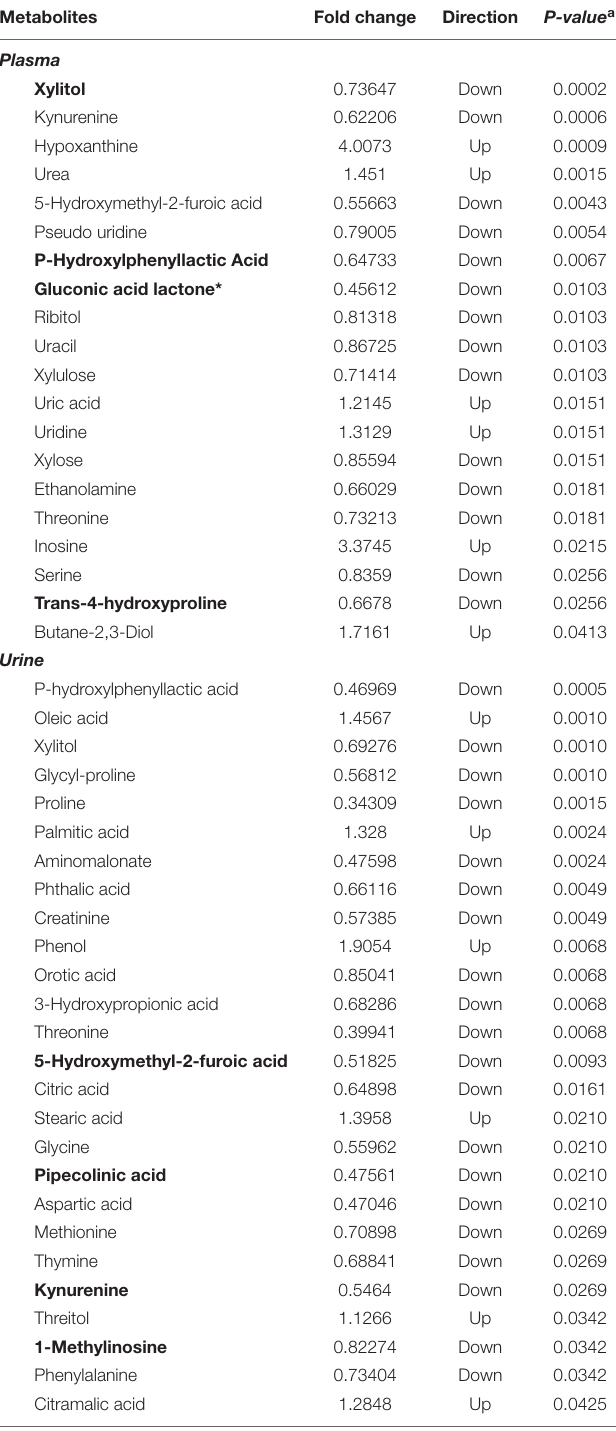
TABLE 2 | List of metabolites significantly associated with pre-post dexamethasone treatment